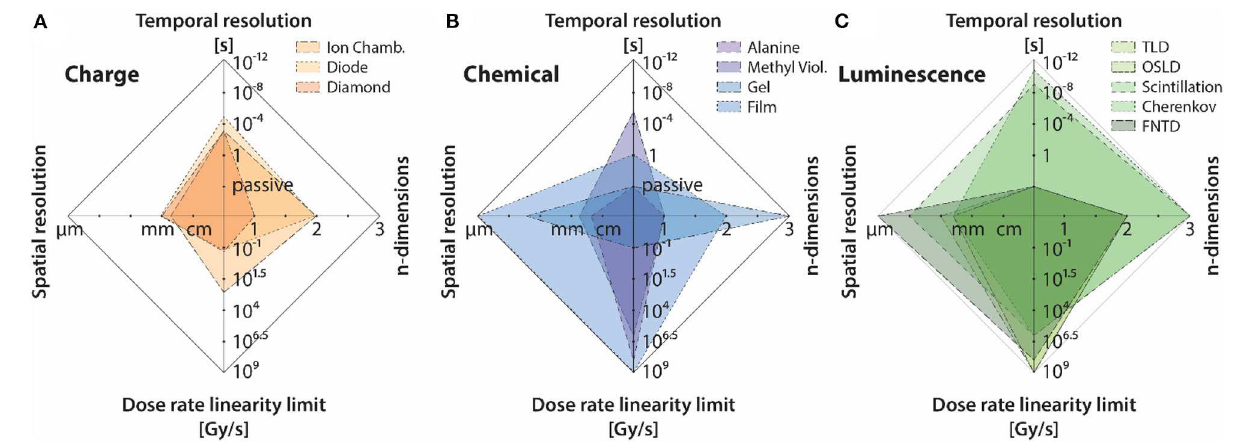
FIGURE 14 | Dosimeter features relevant to FLASH plotted as spider web plots for the three different categories of detectors/tools, including: (A) charge-based dosimetry, (B) chemical dosimetry/actinometry, and (C) luminescence-based dosimetry. The same data is also presented in Table 1 .